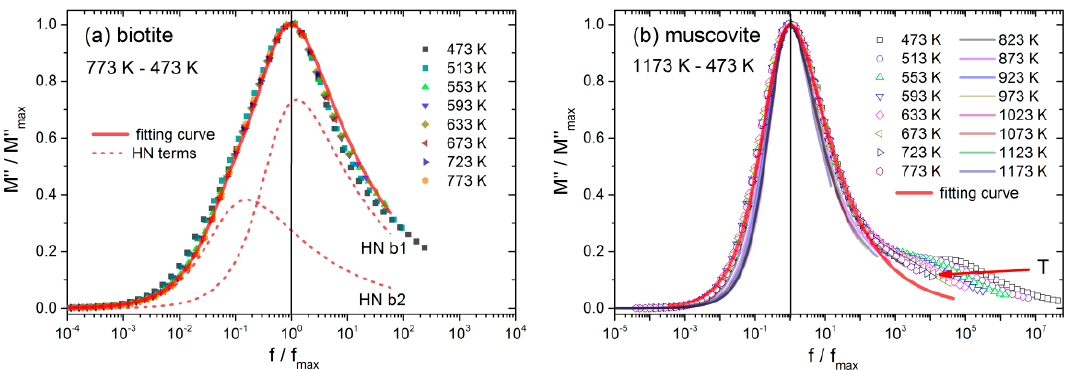
Figure 7. The normalized imaginary part of electric modulus ( M ’’/ M ’’ max ) as a function of normalized frequency ( f / f max ) during the cooling to 473 K for ( a ) biotite and ( b ) muscovite micas. Solid red lines correspond to fitting of data with the Havriliak-Negami relaxation function of Equation (10).